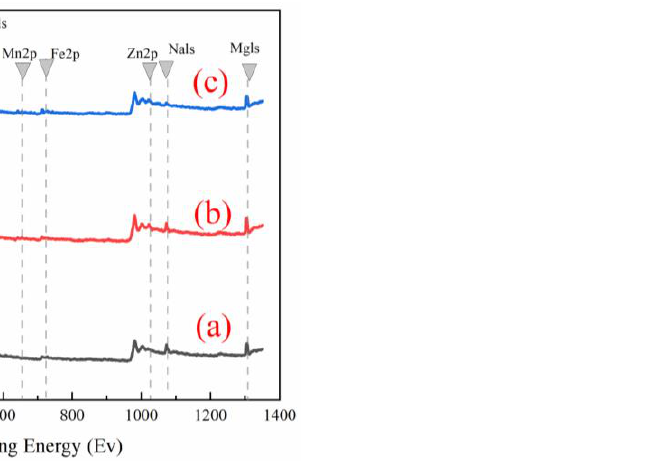
Figure 2. XPS characterization: ( a ) blank; ( b ) Mn/Zn@PG; ( c ) Mn/Zn@PG after utilization 20 times.